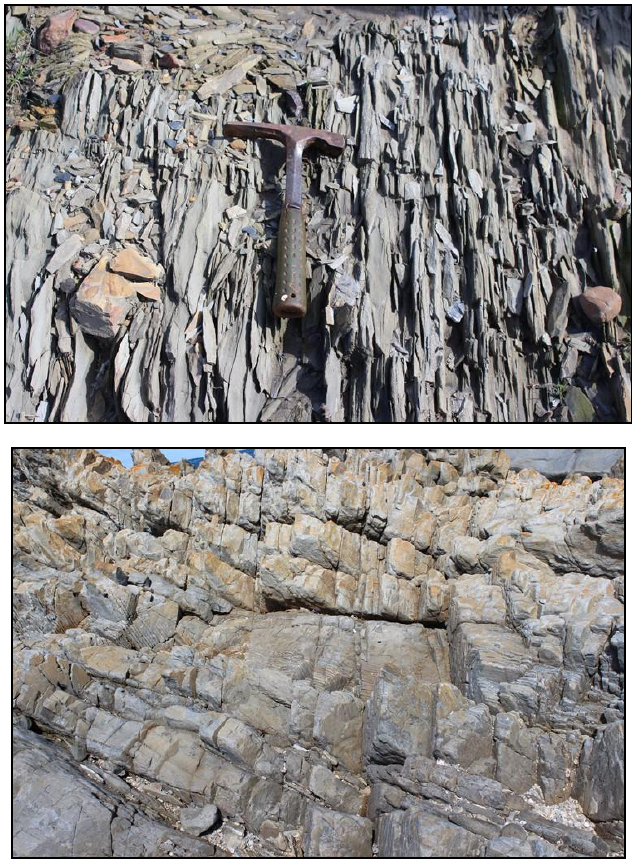
Figure 6. Field photograph showing intensively fractured shale (top) and quartzite (bottom) with inclined fractures along the bedding plane and orthogonal fractures that dissected the rocks.